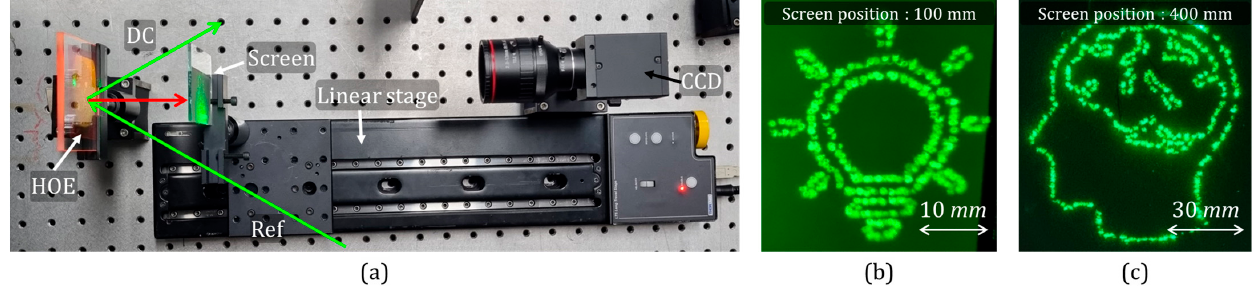
8 of 11 Figure 6. Geometric relation between the rotation angles around the x ‐ and y ‐ axes and tilting angles of the upper and lower goniometers. 4. Experimental Results